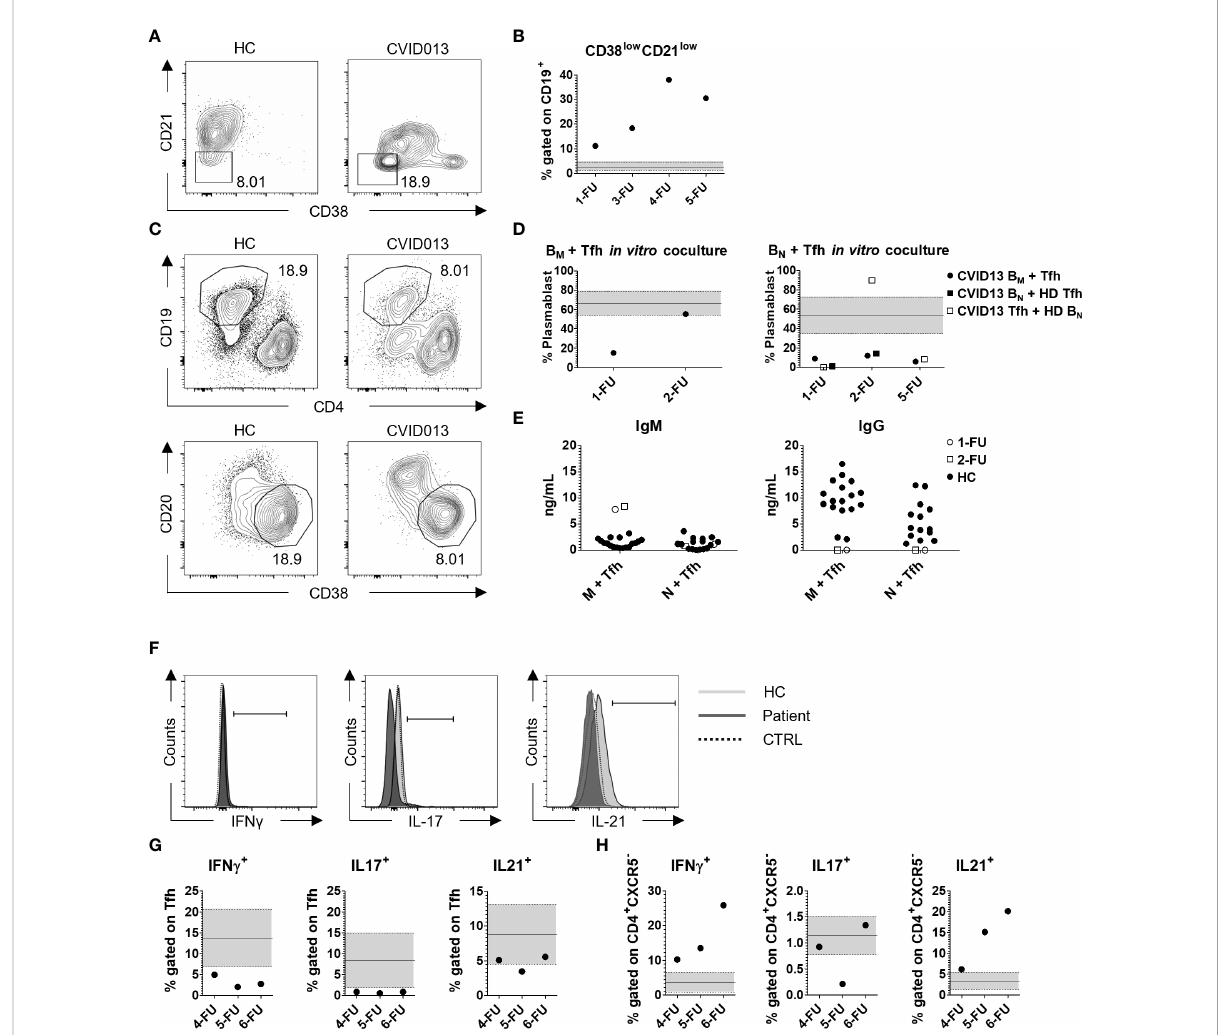
FIGURE 3 Functional analysis of B- and T-cell subsets. (A) Representative gating strategy for CD38 low CD21 low autoreactive B cells, gated on CD19 + cells and (B) their frequency over time. CD38 low CD21 low cell percentage was higher compared with the HC median, IQR (2.42%, 1.3 – 4.58; n = 85), increasing from 11.10% at the fi rst follow-up up to 38.00% in 2020, and decreasing to 30.50% in the last monitoring. (C, D) Functional analysis of IgM and IgG production. Sorted B memory or B naïve cells were co-cultured with Tfh cells (1:1 ratio) in autologous (solid dot) or heterologous settings (CVID B cells with HC Tfh, solid square, or HC B cells with CVID Tfh, clear square), and the percentage of CD38 + CD20 - was analyzed within CD19 + CD4 - cells after 1 week. The black continuous line is representative for the mean HC percentage value ± SD (66.32% ± 12.46, n = 16) represented by the light gray area within the two dashed lines. The production of IgM and IgG was evaluated in the supernatant (E, Table 1 ) . The white dots and squares are representative for the 1-FU and 2-FU, respectively, whereas the black dots represent the HC. (F, G) Evaluation of IFN- g , IL-17, and IL-21 production in CD4 + CXCR5 + cells after 2-h stimulation with PMA/Ionomycin. The HC and patient slopes are identi fi ed with the light and dark gray, respectively, whereas the unstimulated control is represented by the dashed line. IFN- g and IL-17 production was lower compared with the HC (IFN- g mean ± SD = 16.66% ± 6.84; IL-17 mean ± SD = 8.35% ± 6.63; n = 65), whereas IL-21 production was lower than HC mean and comprised within the SD (IL-21 mean ± SD = 8.74% ± 4.30; n = 65). (H) IFN- g , IL-17, and IL-21 production in CD4 + CXCR5 - cells after 2-h stimulation with PMA/Ionomycin. IFN- g and IL-21 production was higher compared with the HC (IFN- g mean ± SD = 3.69% ± 2.86; IL-21 mean ± SD = 3.32% ± 2.06; n = 65), whereas IL-17 production was comparable with HC (IL-17 mean ± SD = 1.14% ± 0.37; n = 65).